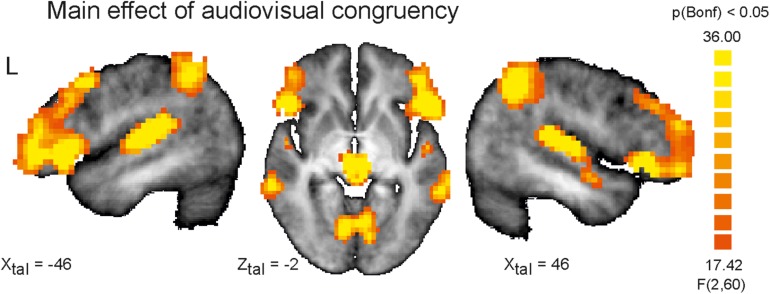
Depicted are sagittal views on the left (L) and right hemisphere and the horizontal view on the averaged brain of the measured population at Talairach coordinates X = 46, –46 and Z = –2. Color coded are voxels that survived conservative significance level of p < 0.05 corrected for multiple comparisons (Bonferroni, Bonf) for the main factor AV congruency. The use of this very conservative significance level was necessary for isolation of separated clusters due to the fact of widespread activation clusters covering almost the whole brain resulting from strong congruency effect and spatial smoothing at the same significance level but corrected for multiple comparisons by means of the false discovery rate.